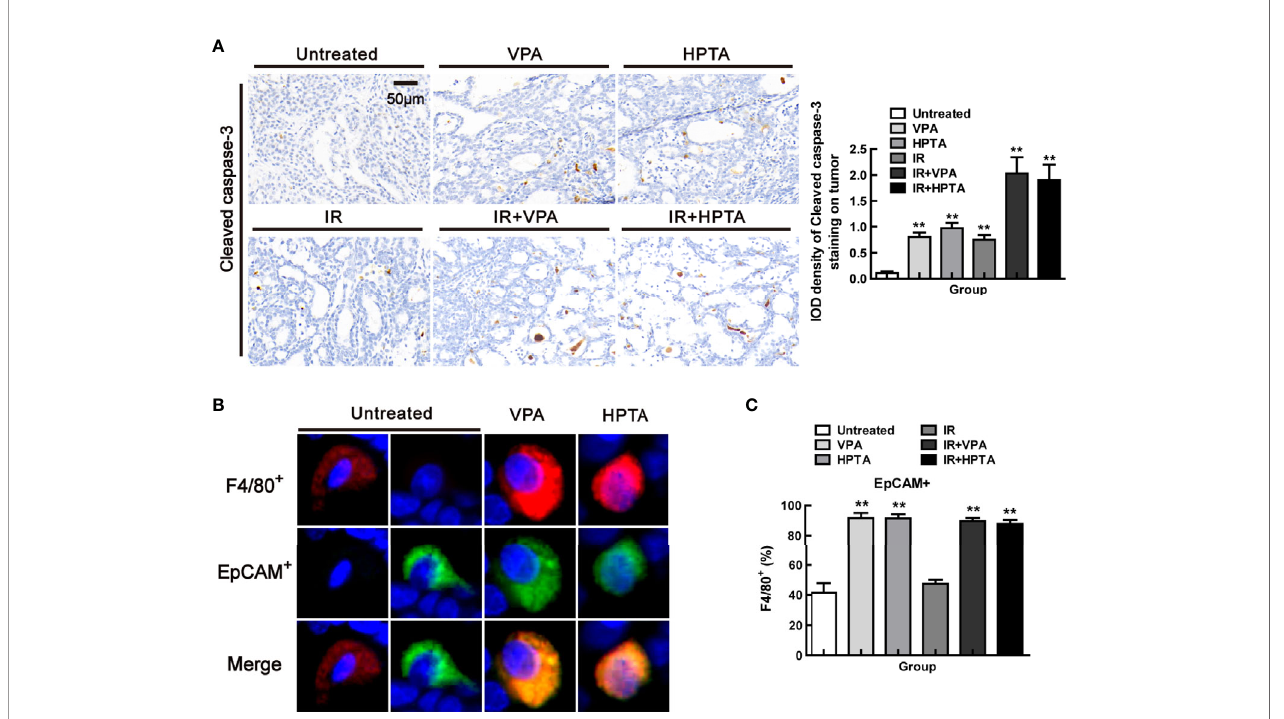
FIGURE 4 | VPA/HPTA-activated macrophages are highly phagocytic in breast tumors at the early stage of treatment in vivo (A) IHC was performed using the cleaved caspase-3 to identify apoptotic bodies within macrophages, representative images and quantitation are shown. Phagocytosis of breast tumor cells was quanti fi ed as the proportion of F4/80+ macrophages (red) that contain intracellular EpCAM+ (green), a marker of breast tumor cells by immuno fl uorescence, representative images (B) and quantitation (C) are shown. Data were normalized to untreated group. Each data point in the graphs was from three independent experiments (mean ± SD). P -values were calculated by Student ’ s t-test (* P < 0.05, ** P <